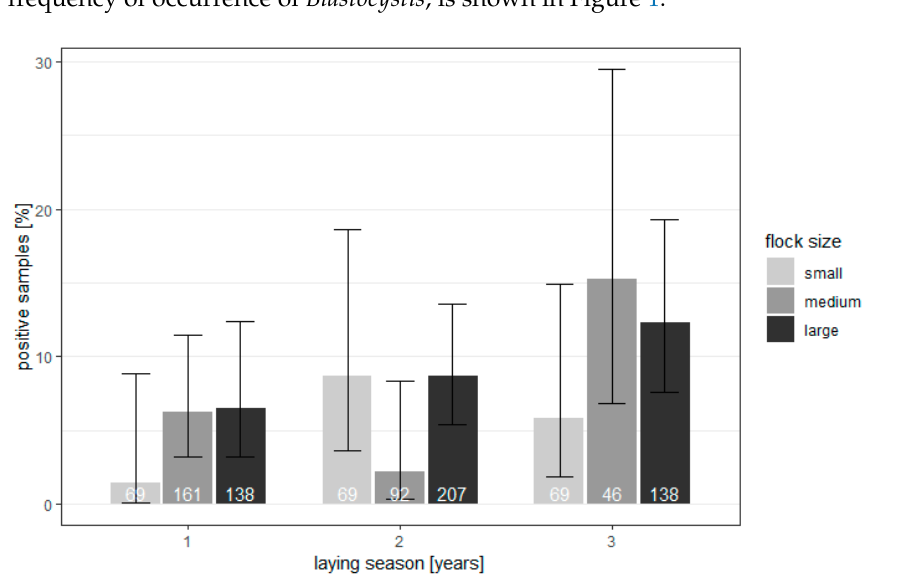
Figure 1. Flock and bird level prevalence of Blastocystis in geese from 43 flocks in Poland (95% con- fidence intervals). confidence